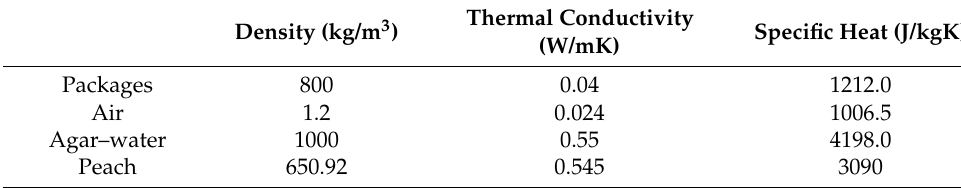
Table 1. Properties of the materials.